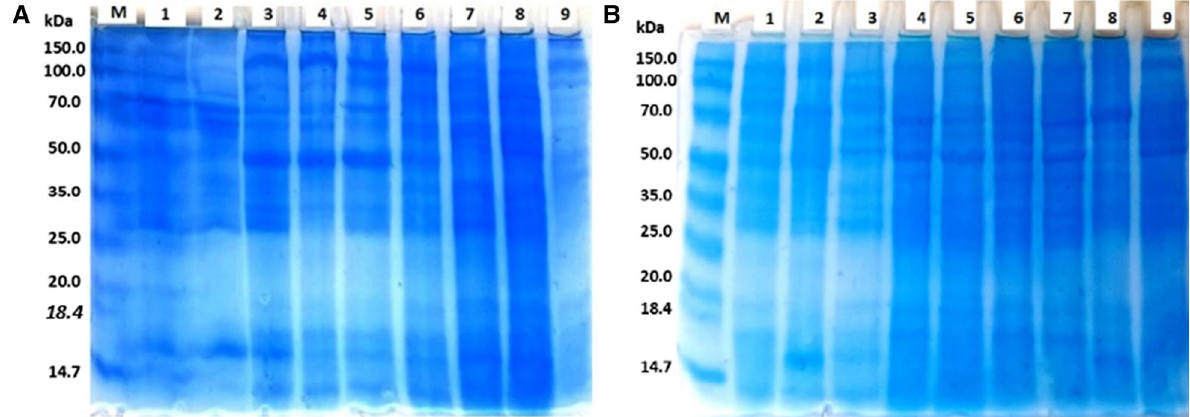
Fig. 2 SDS Gel page for honeybee samples from the three ecological zones during the onset of rain, wet season and dry seasons; M season (A1 and A2 B5 RF; B 6 and B7 =